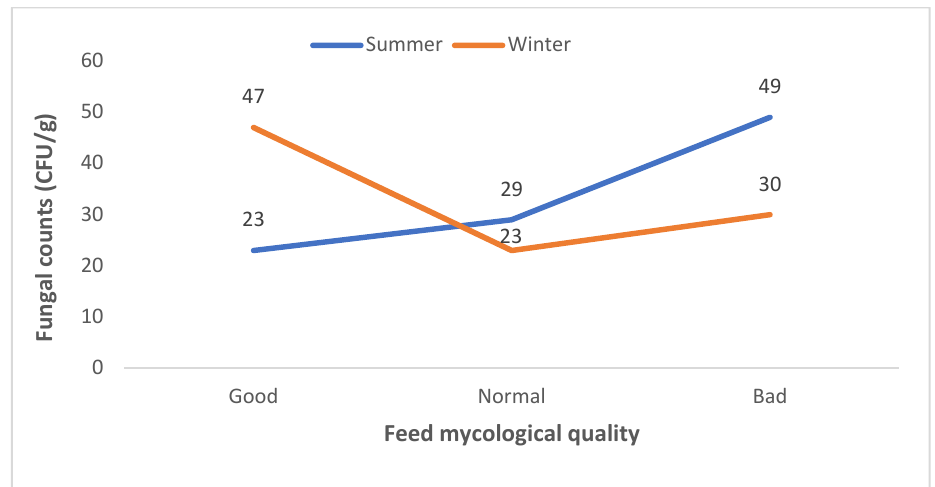
Figure 3. Mycological quality of dairy cattle feeds collected during summer and winter seasons in SA. Table 1. Mean fungal loads and fungal genera recovered from smallholder dairy cattle feeds and feedstuffs from Free State and Limpopo provinces, South Africa.